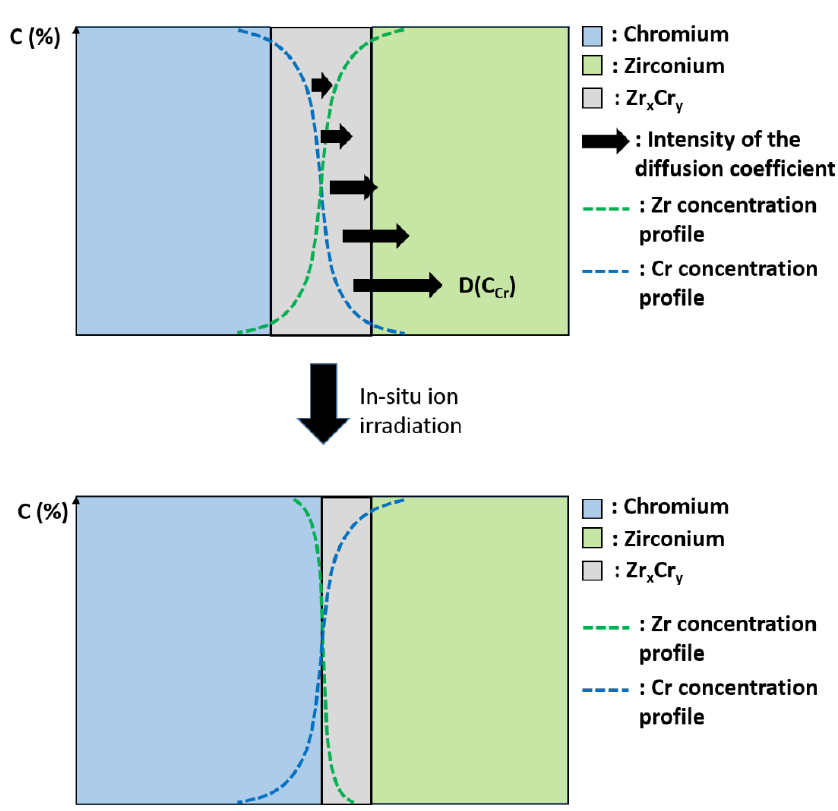
Figure 8. Schematic representation of the sharpening effect caused by asymmetry of the diffusion